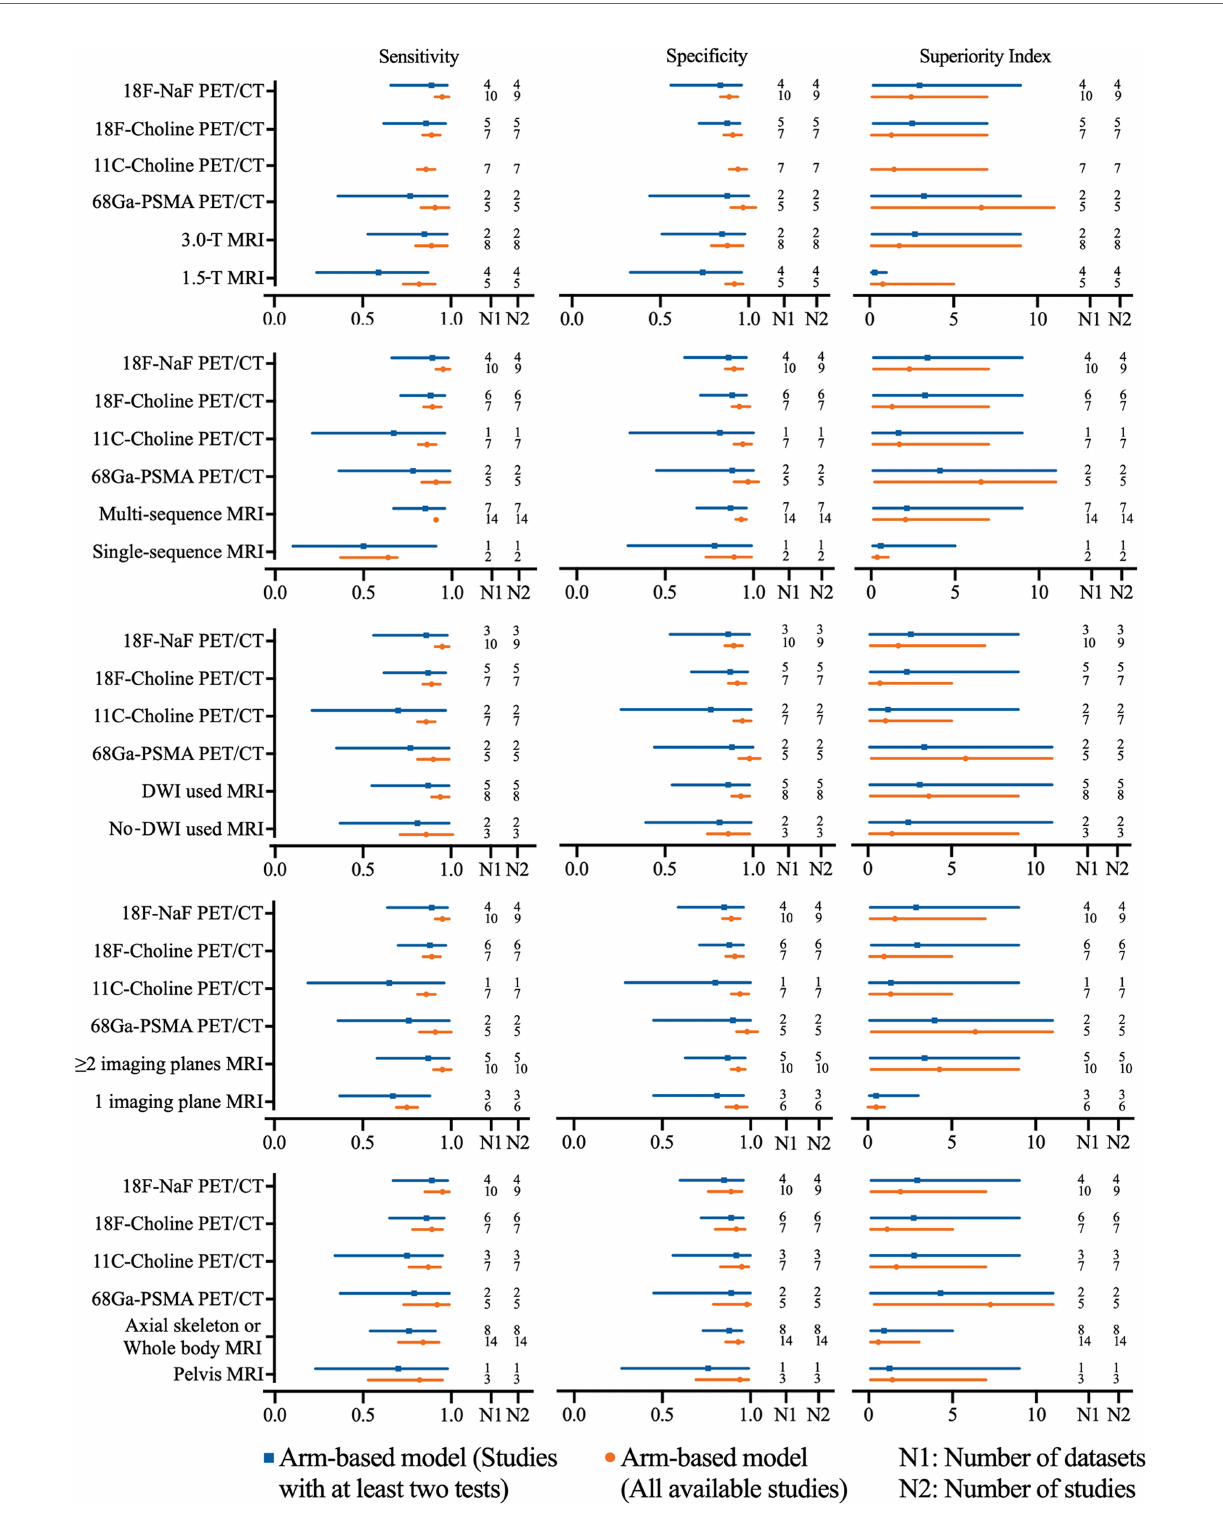
FIGURE 3 | Network meta-analysis results including sensitivity, speci fi city, and superiority index values of PET/CT with four commonly used tracers and MRI with numerous characteristics for the detection of bone metastasis. Sensitivity, speci fi city, and superiority index are reported as mean (range) unless otherwise indicated. PET/CT, positron emission tomography/computed tomography; NaF, sodium fl uoride; PSMA, prostate membrane antigen; DWI, diffusion-weighted imaging.